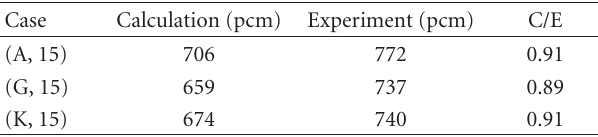
Table 2: Comparison between the measured and calculated subcrit- icalities obtained from the experiments (Figure 5) and calculations (MCNPX with